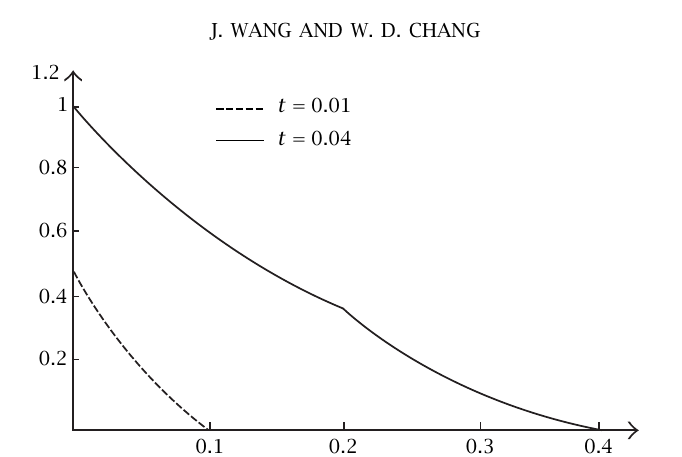
Figure 5.1 . Temperature θ/θ 0 versus x in the ramp-type heating problem.